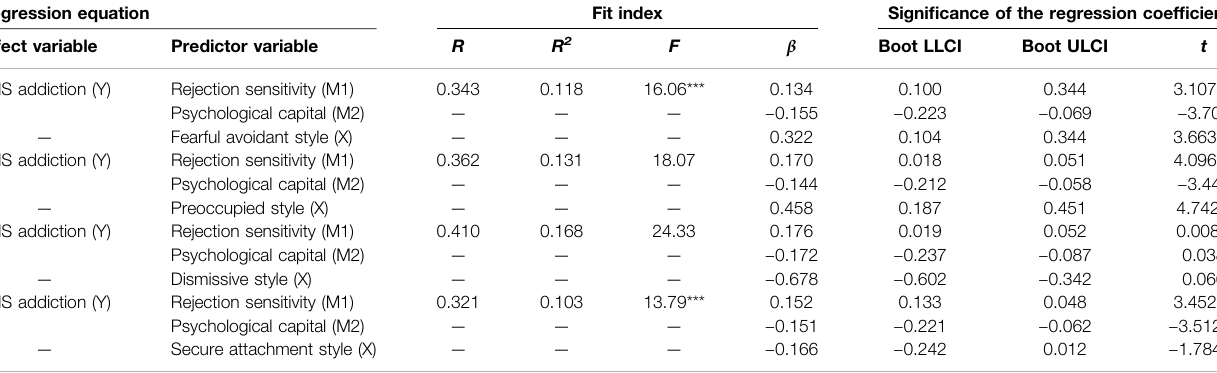
TABLE 4 | Analysis of multiple mediating effects of four dimension of attachment style with demographic variables as covariates. Regression equation